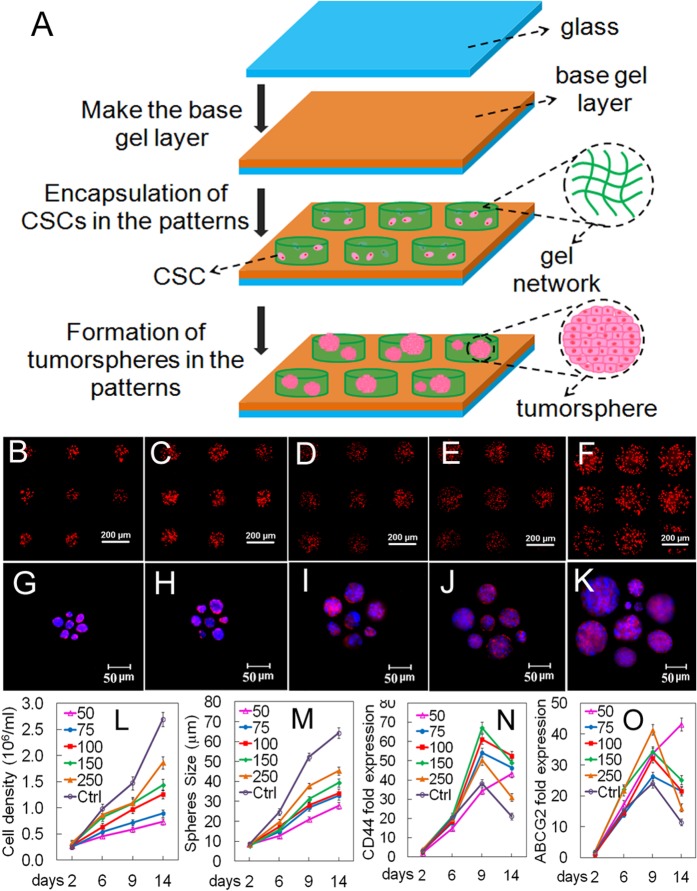
Dependence of tumorsphere growth on niche size for MDA231 cells.(A) Procedure for cell encapsulation in the micropatterned gel. CellTracker stained images of MDA231 cells encapsulated in the 5 kPa gel with circular patterns with diameter of 50 (B), 75 (C), 100 (D), 150 (E), and 250 (F) μm after 2 days of incubation (scale bars in B-F are 200 μm). DAPI (blue) and phalloidin (red) stained images of 7 representative tumorspheres formed by the encapsulated cells in (B-F) from different sections of the patterned gels after 14 days of incubation with 50 (G), 75 (H), 100 (I), 150 (J), and 250 (K) μm patterns (scale bars in G-K are 50 μm). Note that the 7 representative tumorspheres in (G-K) are from multiple patterns in the gel sample, not a single pattern, to show size range and shape of tumorspheres for a given pattern size. Cell number (L), average tumorsphere size (M), CD44 expression (N), and ABCG2 expression (O) of the cells in (B-F) with incubation time for 50 (pink), 75 (blue), 100 (red), 150 (green), 250 (brown) μm patterns, and un-patterned gel (purple). Error bars in (L-O) correspond to mean±1 SD for n = 3.